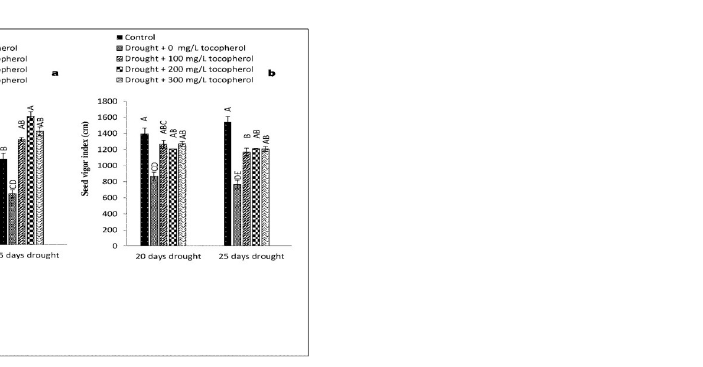
Fig 3. Effect of varying levels of exogenously applied α -tocopherol on leaf area ratio ( a ) seed vigor index ( b ) of lentil ( Lens culinaris Medik.) grown under varying drought stress condition (Mean ± standard error.) letters (A–E) indicating least significance difference among the mean values at p �